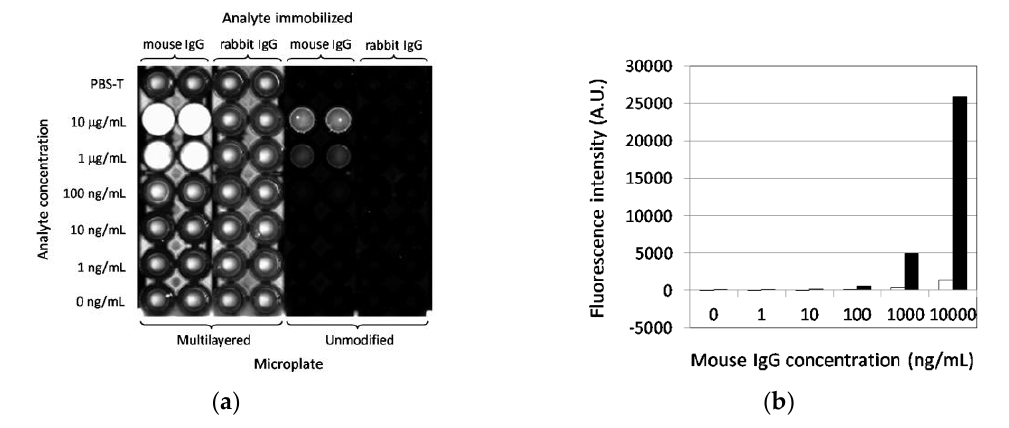
Figure 5. Effect of the multilayer structure on the immunoassay. Antigen-antibody interaction was evaluated using Cy3-labeled anti-mouse IgG antibody on the unmodified or multilayered microplate. ( a ) Two-dimensional fluorescence image of microplates scanned after immunoreaction; ( b ) Fluorescence intensity as a function of mouse IgG concentration obtained with the unmodified (white bars) and multilayered (black bars) microplates. Averages of two measurements are demonstrated .